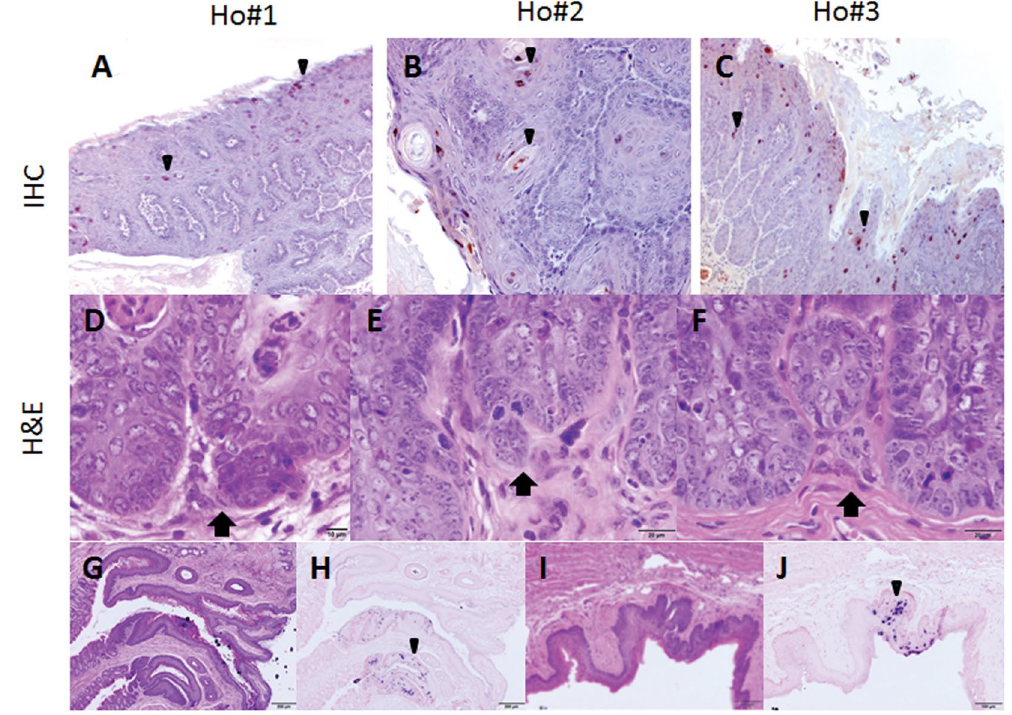
Figure 6. NU/J homozygous (immunocompromised) mice exhibited infections in mucosal tissues. MmuPV1- infected vaginal tissues exhibited dysplasia in the homozygous NU/J mice. Mice were sacrificed at 7.5 months post-infection and tissues were examined for histological changes. Viral capsid protein was detected in these tissues by immunohistochemistry with an in-house anti-MmuPV1 antibody (MPV.B9) (Ho#1-#3, A – C , 10 × , and arrows). Scattered foci of ambiguous micro invasion were found in the lower genital tract of these homozygous NU/J mice ( D – F , 20 × , and arrows). Infections at the anal and oral sites were examined by histology. There was diffuse mild hyperplasia and hyperkeratosis of the stratified squamous cornifying epithelium of the anal canal ( G , 10 × , and arrows). There was minimal atypia or obvious viral cytopathic effect (CPE), with low to moderate numbers of ISH positive cells, mostly located near the recto-anal junction ( H , 10 × , and arrows). A small plaque was found on the ventral surface of the tongue just rostral to the duct of the sublingual salivary gland ( I ) and was positive for viral DNA ( J , 10 × , and arrows).